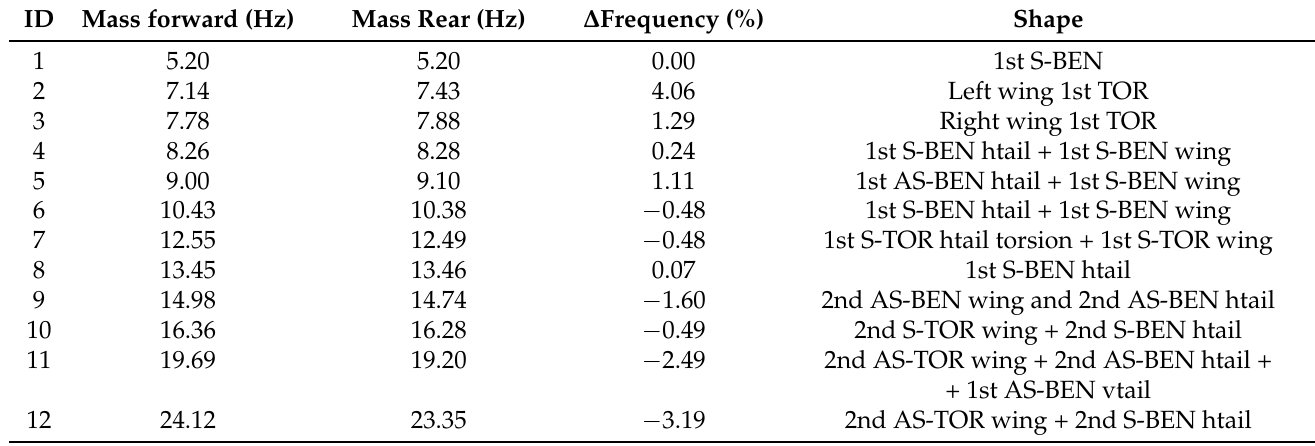
Figure 5. CrossMAC between measured mode shapes with tip masses in forward and rear positions. Table 1. Comparison among frequencies with tip masses in forward and rear positions (BEN = bending; TOR = torsion; S = symmetric; AS =